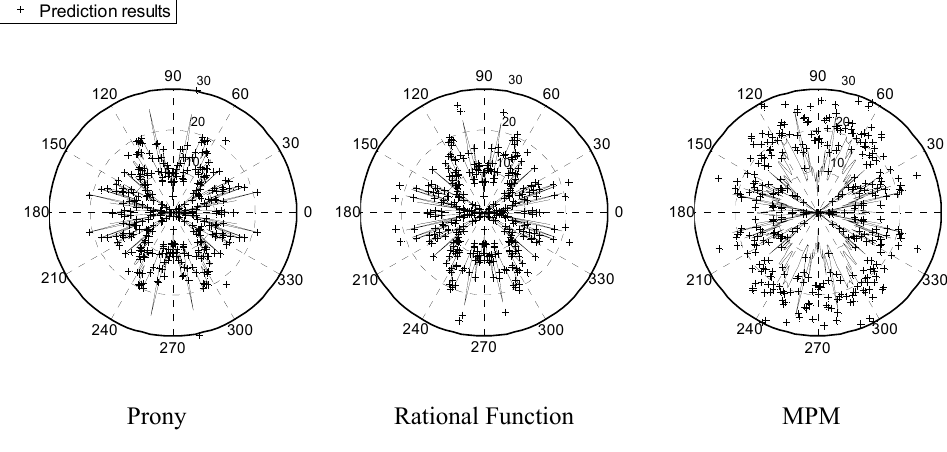
Figure 12. Jet Plane Prediction results in all directions at 7 GHz.